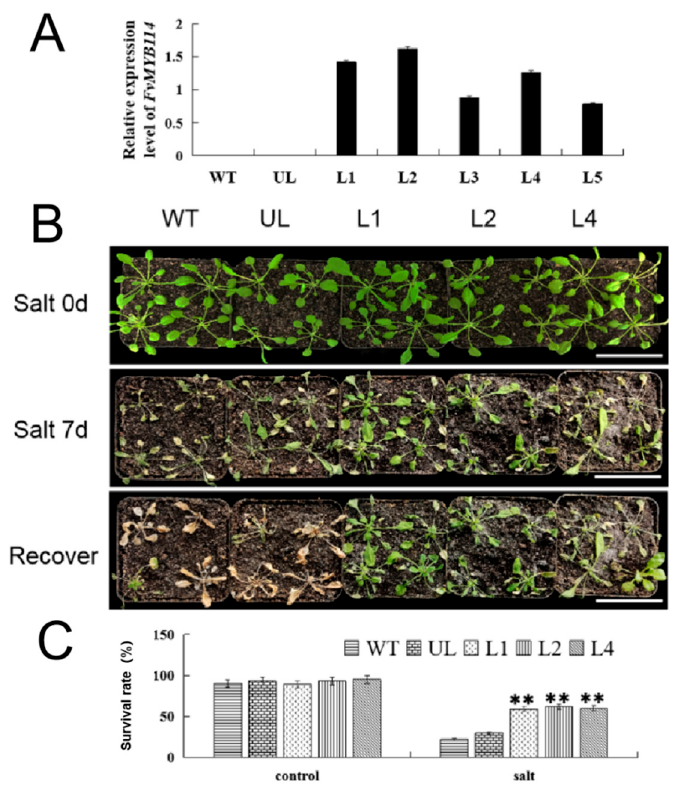
Figure 5. Growth of FvMYB114 -OE A. thaliana after salt stress. ( A ) The relative expression levels of FvMYB114 in WT, UL and FvMYB114 -OE lines. ( B ) The phenotypes of WT, UL and transgenic lines (L1, L2 and L4) under control conditions, salt stress and stress recovery conditions. Bar = 5 cm. ( C ) Survival rates of each line (WT, UL, L1, L2 and L4) under different treatments. ** SD between transgenic lines and WT and UL, p ≤ 0.01.